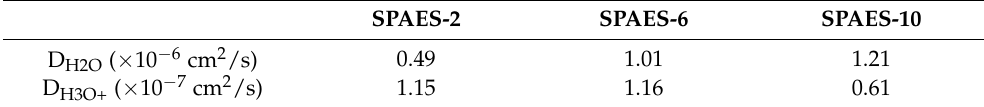
Figure 4. MSDs of ( a ) water molecules and ( b ) hydronium ions inside the SPAES membranes. Table 2. Diffusion coefficients of H 2 O and H 3 O + in the hydrated SPAES